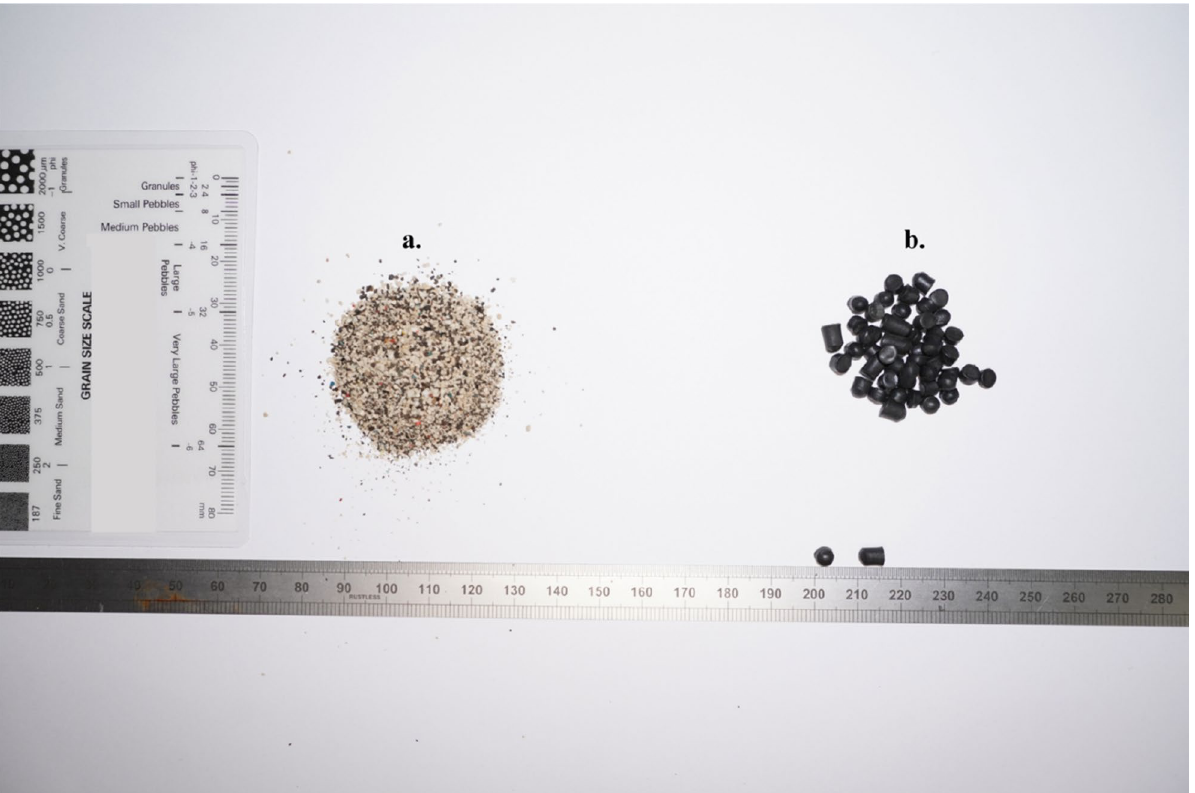
Figure 10. Microplastics, ( a ) Bakelite particles and ( b ) PVC nurdles, deployed in the